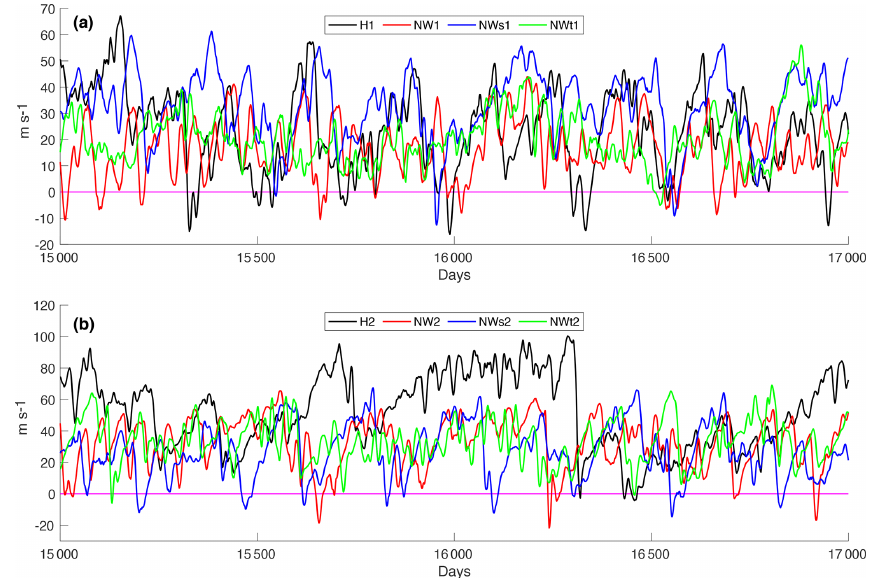
Figure 7. Zonal-mean zonal wind at 10hPa and 60 ◦ N for H1 and H2 (black), NW1 and NW2 (red), NWs1 and NWs2 (blue), and NWt1 and NWt2 (green) for model runs with wave 1 (a) and wave 2 (b) heating. The data were smoothed with a 10d filter. The magenta line marks 0ms − 1